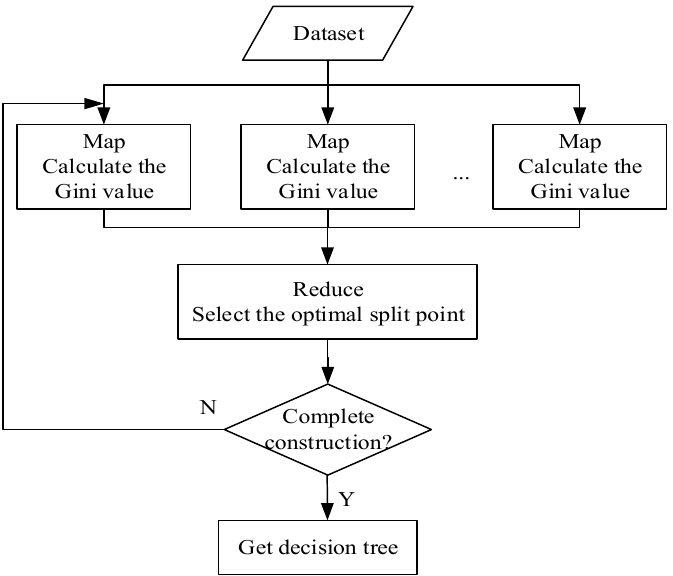
Figure 6. The specific tree construction process in Map task.